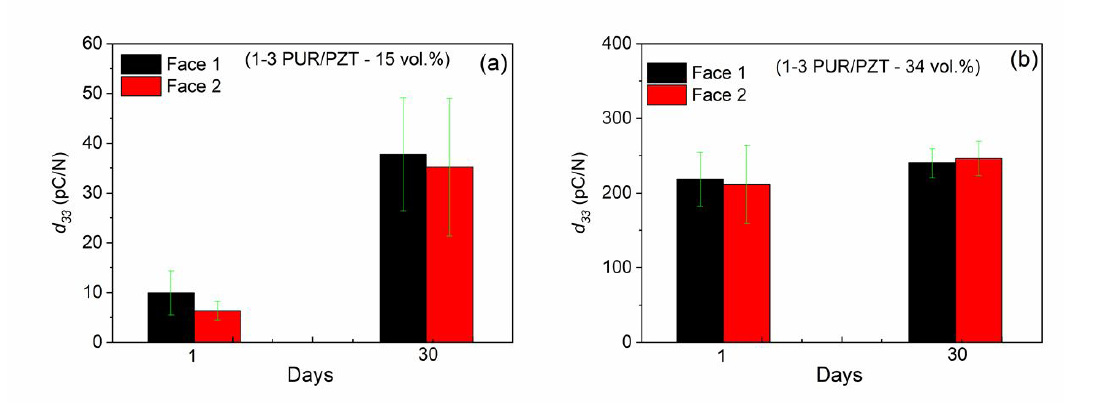
values obtained for 1-3 PUR/PZT composite samples with 15 vol.% (45 rods) and 34 vol.% (90 rods) of PZT. Measurements Figure 7. d 33 carried out one and 30 d after polarization. The face 1 and face 2 refers to the face of the sample that was subjected to the positive and negative pole of the polarization source, respectively. value of the 1-3 PUR/PZT 1-3 composite samples and works in the literature. Table 2. Comparative analysis of the d 33